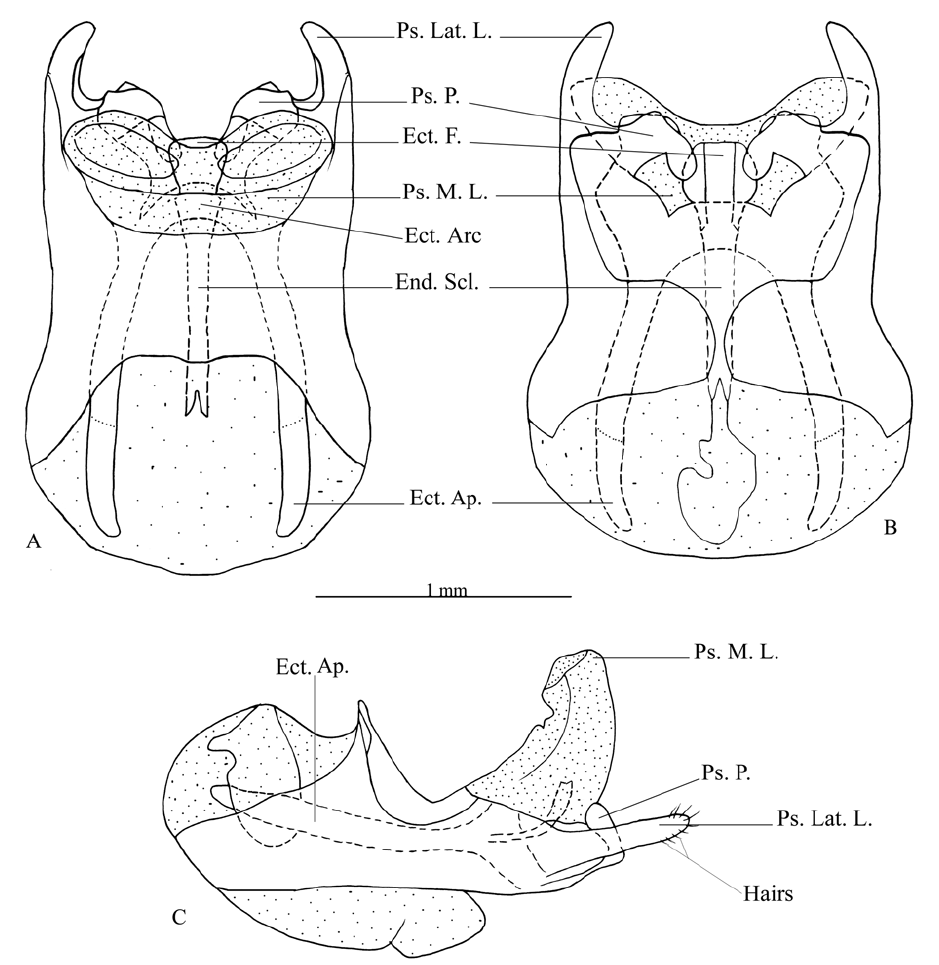
Fig. 5 – Male genitalia of P. bauxitica sp. nov. A. dorsal, B. ventral and C. lateral view. Abbreviations: Ps. Lat. L.: pseudepiphallic lateral lobes / Ps. P.: pseudepiphallic paramere / Ps. M. L.: pseudepiphallic median lobe / Ect. F.: ectophallic fold / Ect. Arc: ectophallic arc / Ect. Scl.: ectophallic sclerite / End. Ap.: endophallic